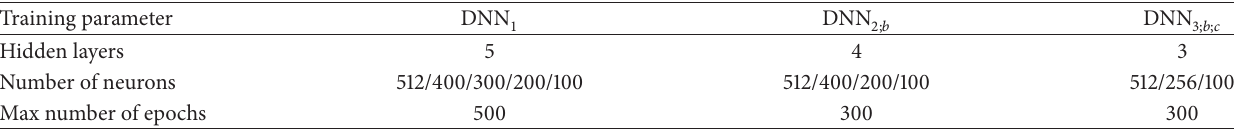
Table 3: DNN model parameters.